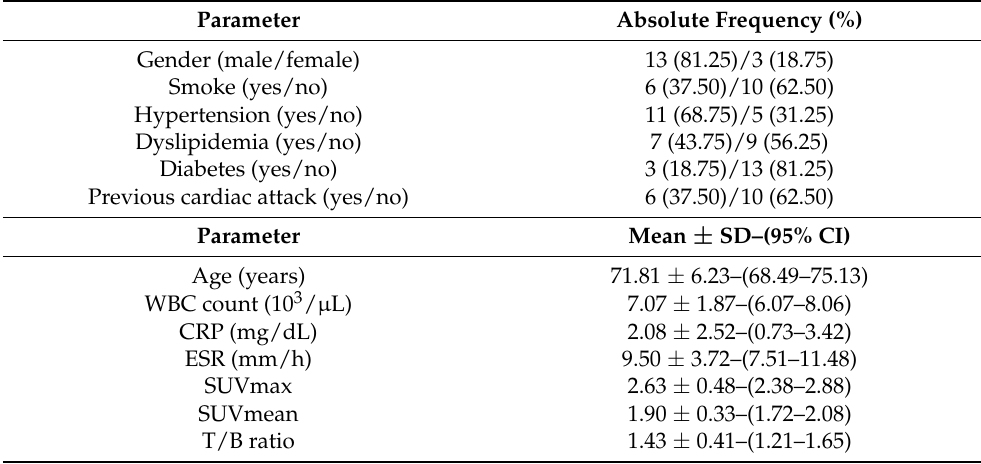
Table 1. Characteristics of studied population.